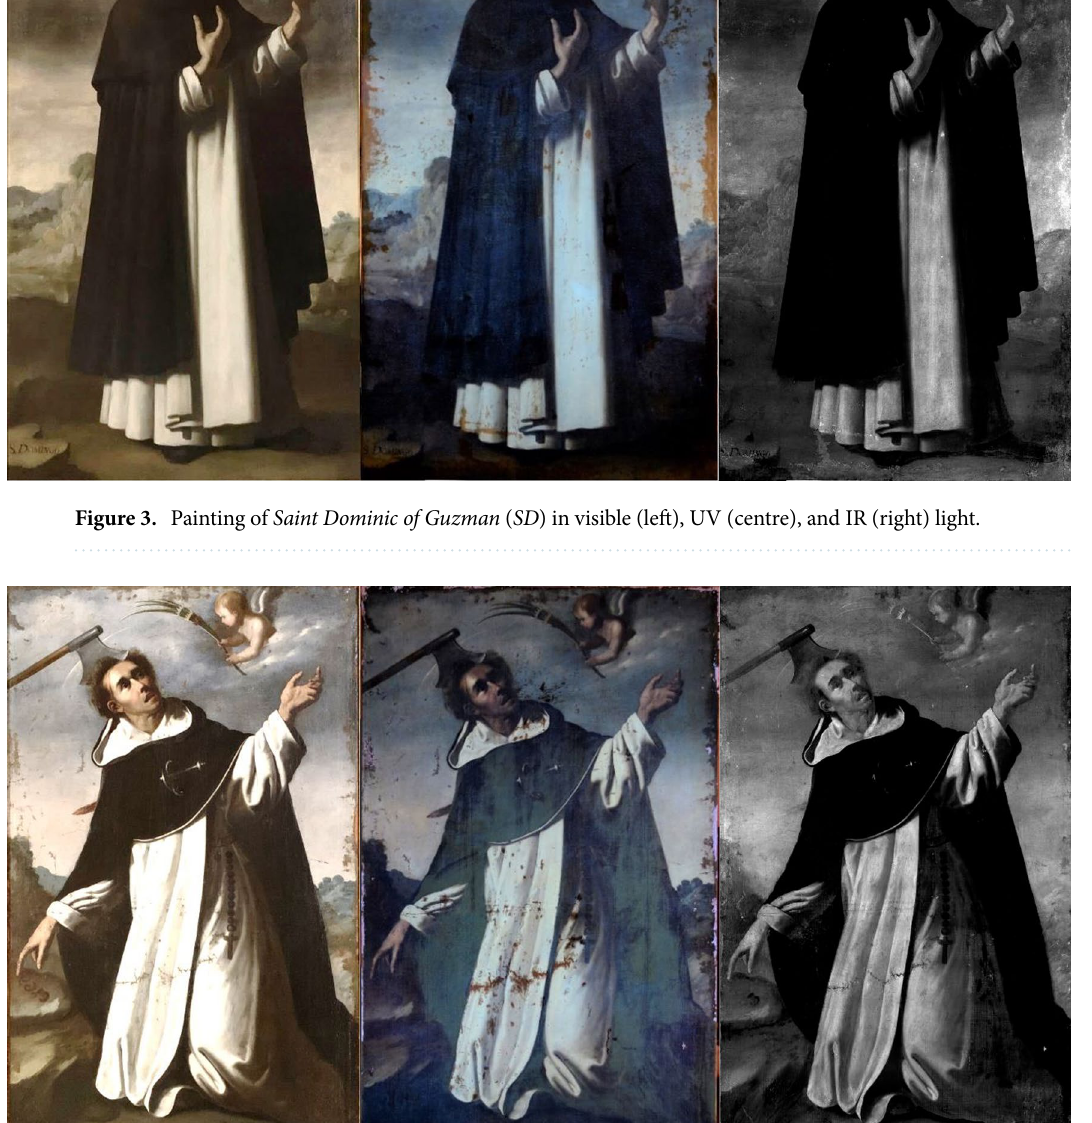
ments and those used in the interventions. In addition, a comparison between the paintings was carried out to find differences that could indicate different authors. Preparation and priming. All areas analysed with XRF showed the presence of Ca, Fe, and Pb peaks, which may indicate that these elements belong to the preparation and primer layers. The intensity of the peaks depends on the thickness of the superimposed pictorial layers and the pigments used. A Ca-based preparation was con- firmed by the analysis of the areas with polychromy loss, in which the preparation or the canvas could be seen